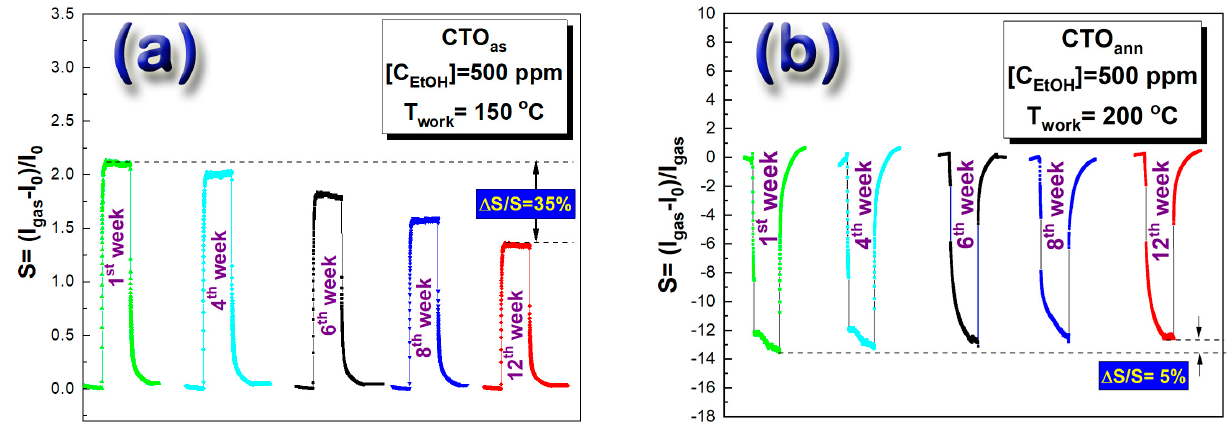
Figure 8. Stability investigation of samples under 500 ppm of ethanol vapor at the optimum tempera- tures: ( a ) CTO as and ( b ) CTO ann . Table 2. Comparative study of Co 2 SnO 4 / Co 3 O 4 composite (CTO ann ) ethanol sensing parameters with other ethanol sensing materials.